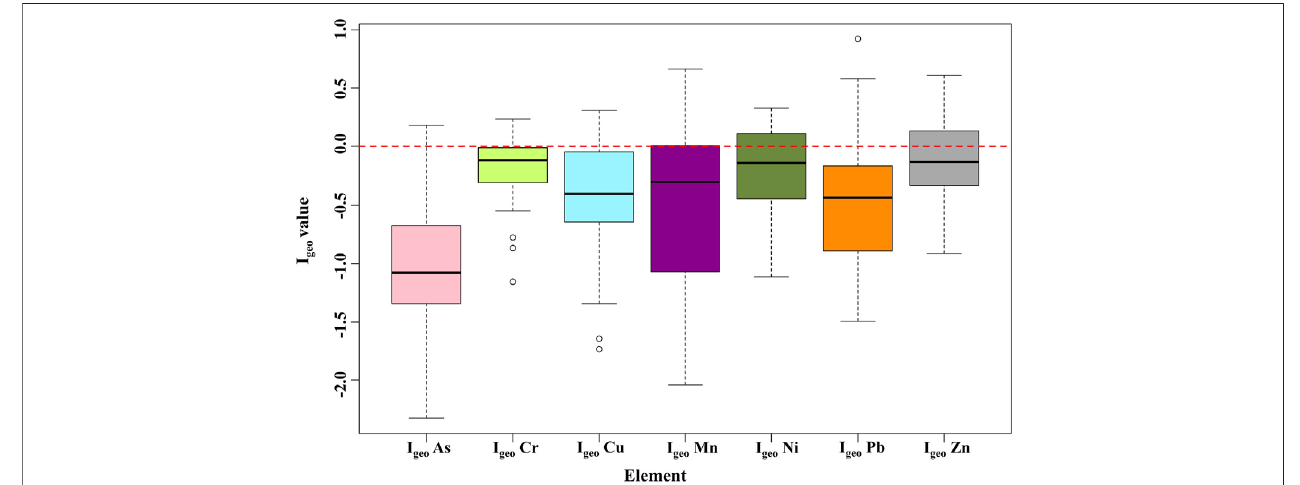
FIGURE 2 | Box plot of the relationship between the geo-accumulation index and heavy metal elements.